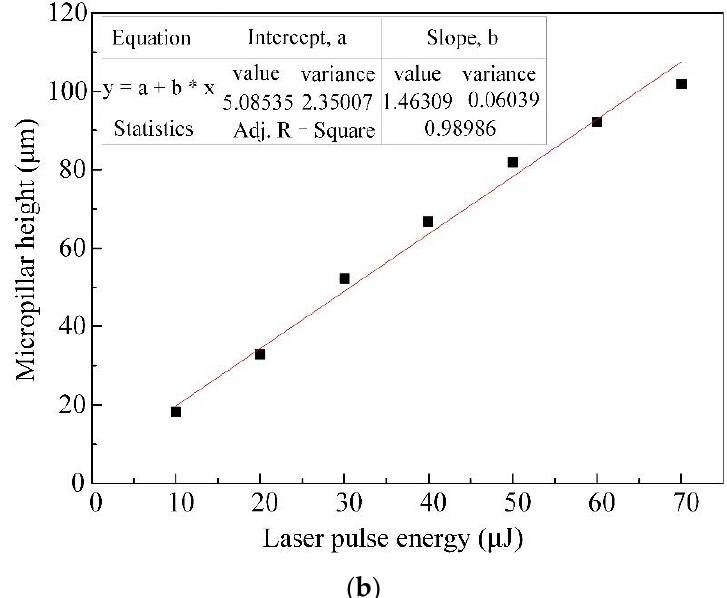
Figure 4. Effect of pulsed beam energies on the mean height of micropillars with a translation velocity of 1.0 m/s and a pulsed repetition rate of 600 kHz. ( a ) Measurements of micropillar height against laser pulse energy. ( b ) Linear fitting of micropillar height against laser pulse energy.